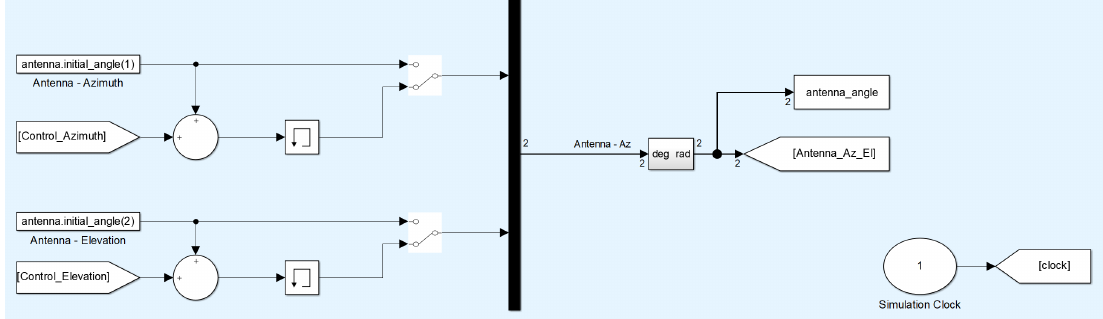
Figure 16. The Simulink model to adjust the pointing angle of the antenna using the existing angle and the output of the tracking system.